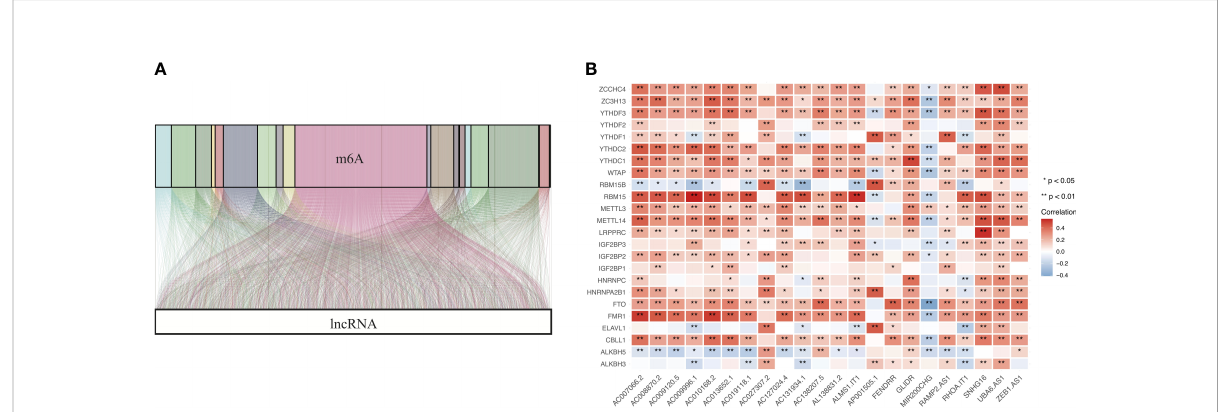
FIGURE 3 Identi fi cation of m6A-related lncRNAs in COAD. (A) Sankey coexpression diagram for m6A modulators and m6A-related lncRNAs. (B) Heatmap exhibiting the correlations of 24 m6A modulators with 22 prognostic m6A-related